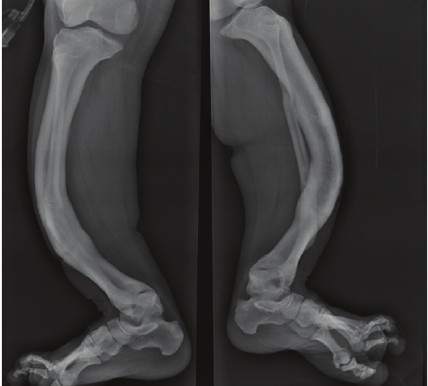
Figure 2: X-ray showing bowing of long bones.